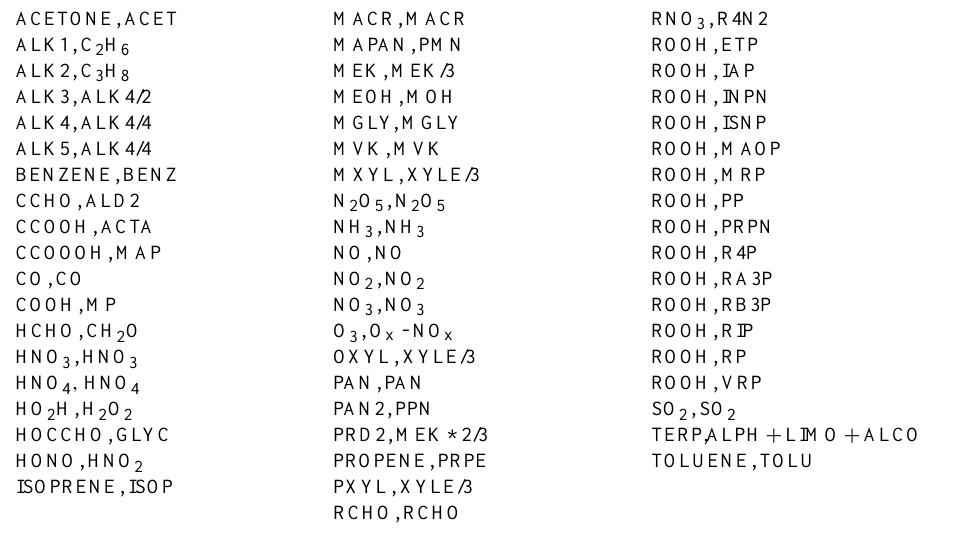
Table A2. SAPRC07 species mapping in the form SAPRC07 Species, GEOS-Chem expression. ACETONE, ACET